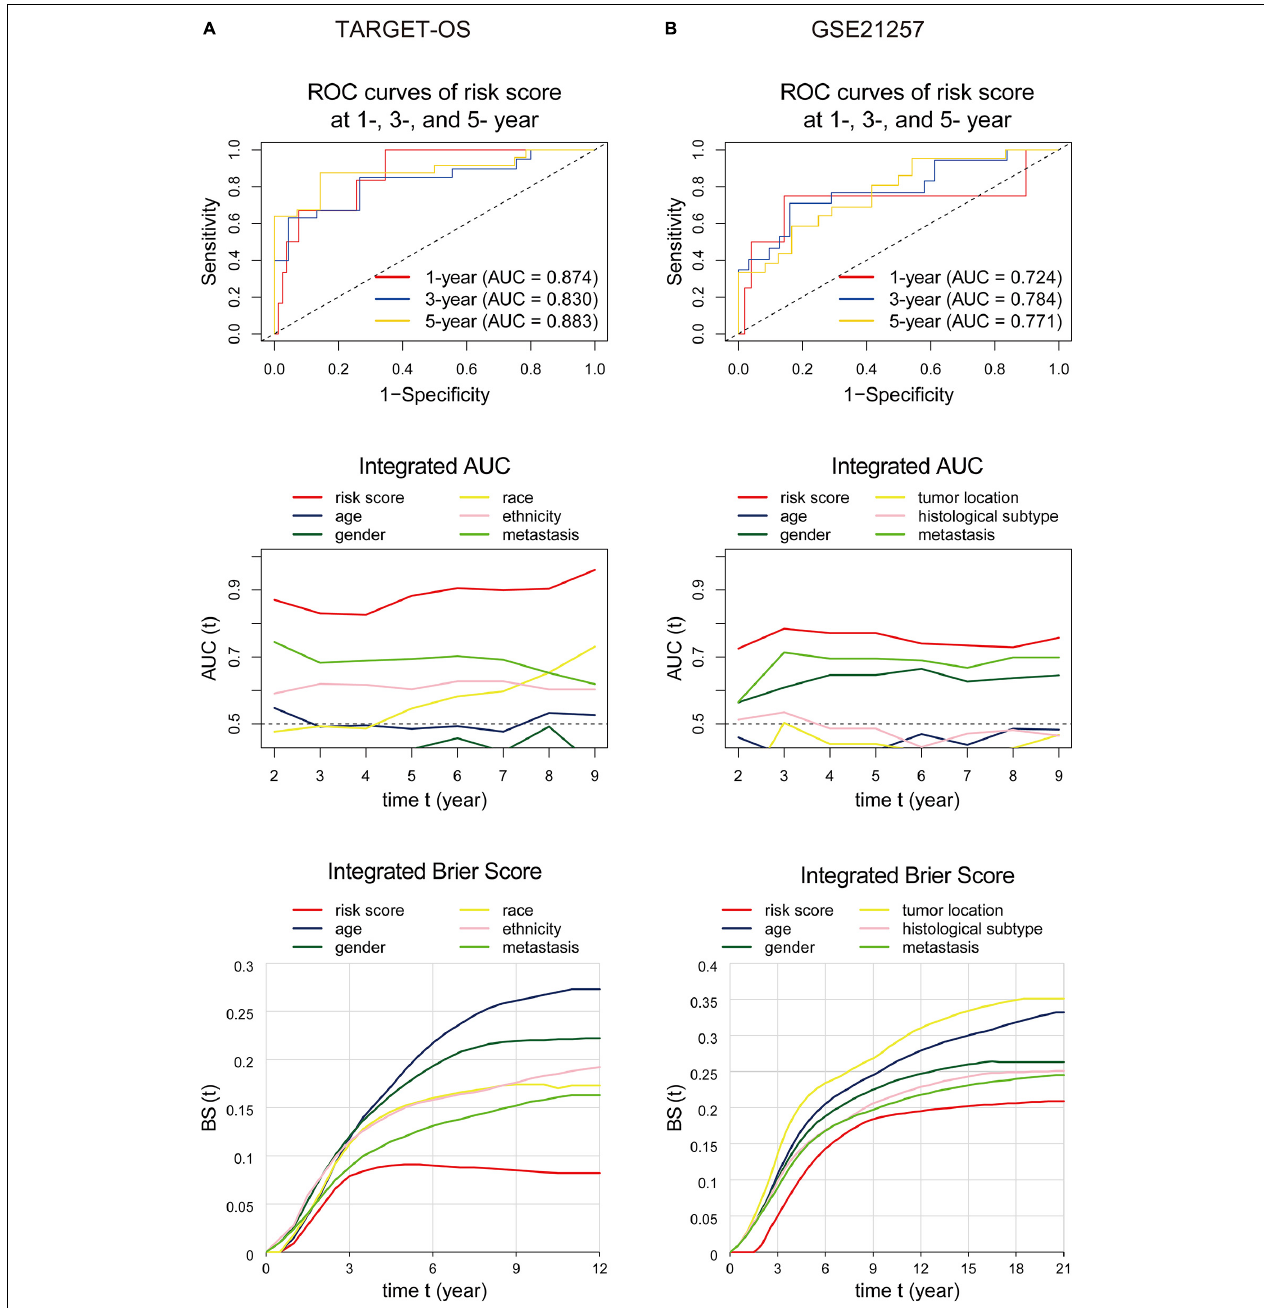
FIGURE 7 | ROC curves, integrated AUC analysis, and integrated Brier score analysis performed to examine the predictive ability of the nine-gene signature in the training (A) and validation (B) cohorts. The ROC curvesdisplay prognostic capacities with the nine-gene signature at 1-, 3-, and 5-year time points. The integrated AUC and integrated Brier score analysis show the predictive ability comparisons between the nine-gene signature and other clinical factors. ROC, receiver operating characteristic; AUC, area under the ROC